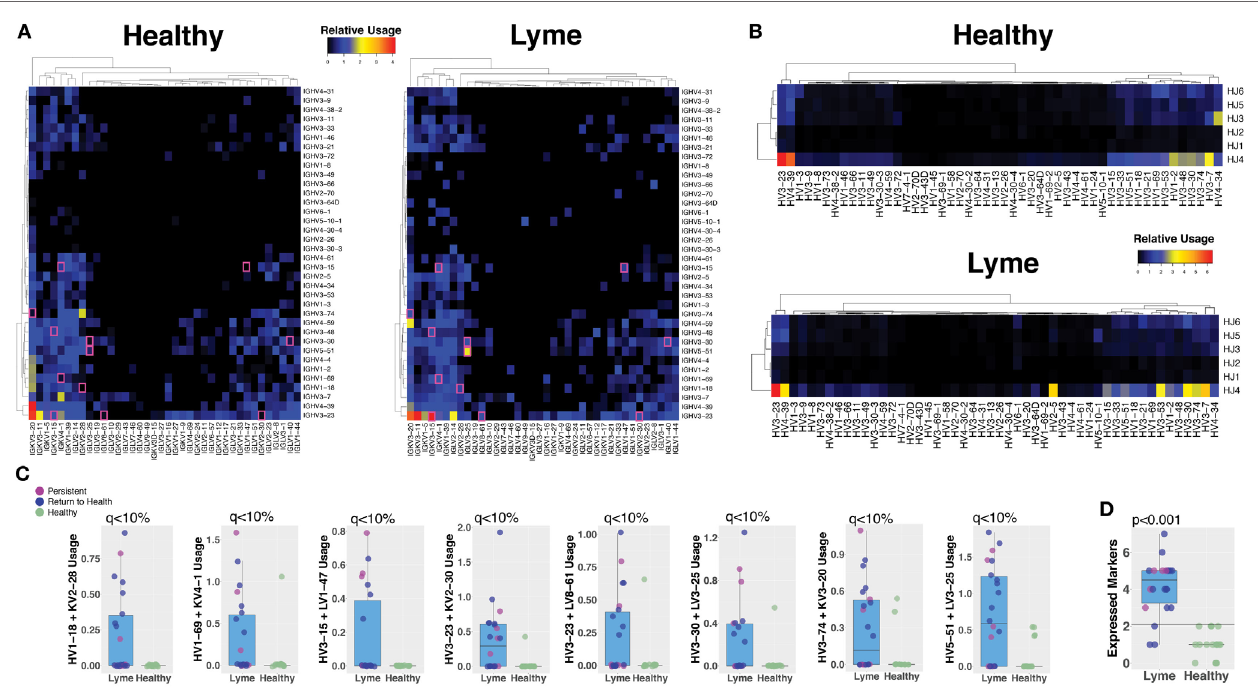
FigUre 5 | Sequencing the paired-chain plasmablast antibody repertoires, but not HC sequencing of bulk blood B cells, reveals preferred gene segment usage in Lyme disease. Predicted V and J gene segment usage by plasmablasts (heavy and light chain) and total B cells (heavy chain) were identified by alignment with the IMmunoGeneTics database. The percent usage of each gene combination was compared between Lyme disease patients and healthy controls. (a) The relative number of paired plasmablast sequences using a given heavy- and light-chain V and J gene combination was compared between untreated Lyme disease patients and healthy controls, and the median value from each group is displayed on the heatmap. The presented heatmap is subsetted to show only the most frequent combinations from among all subjects, with significantly different combinations ( q < 10%) highlighted in a pink box. (B) Heavy-chain gene segment usage for bulk B cell sequencing was calculated as the relative usage of a given predicted heavy-chain V and J gene combination. (c) Representative gene combinations preferentially enriched or reduced in Lyme disease were plotted to show individual subject values and statistics. (D) Number of expressed V-gene-combination markers for each patient, of eight selected markers. Using a cutoff of > 2 markers, the maximum number observed for healthy controls provides 84% sensitivity and 100% specificity for Lyme disease. Q values were calculated by Significance Analysis of Microarray with the Wilcoxon Rank-Sum test (a–c) . P values were calculated using the Student’s t -test (D)